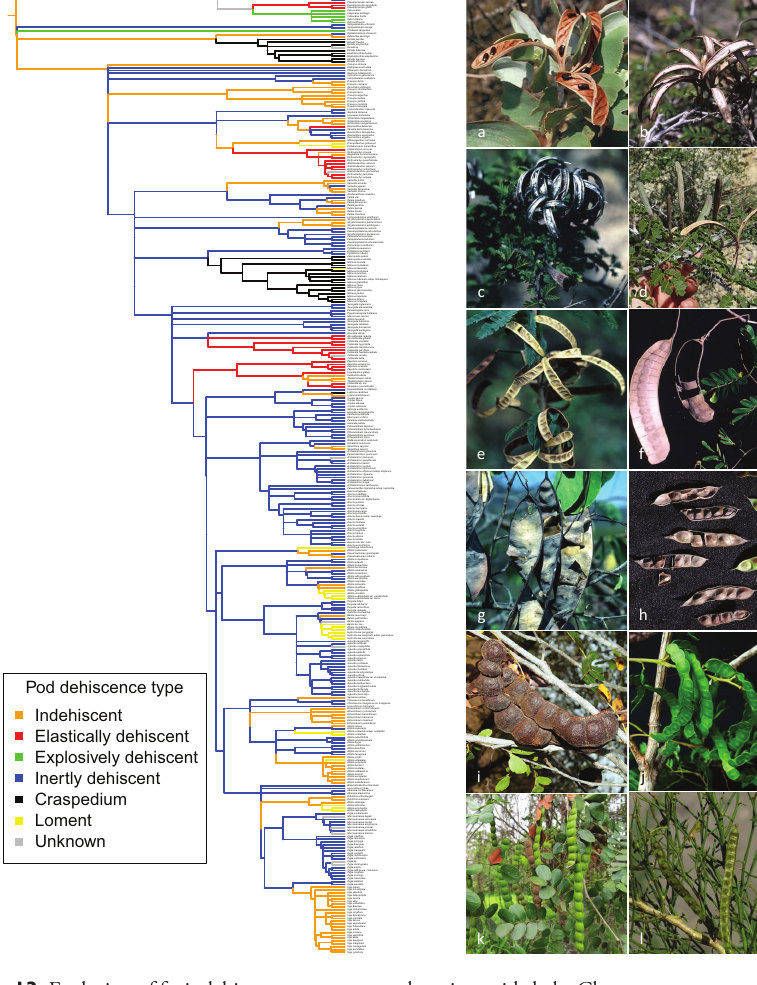
Figure 13. Evolution of fruit dehiscence types across the mimosoid clade. Character states were defined as: indehiscent ; inertly dehiscent along one or both sutures; explosively dehiscent , whereby the woody valves twist and split along both sutures along whole length of pod simultaneously; elastically dehiscent from the apex, the valves recurving, but not laterally twisting; craspedium , i.e. fruits breaking up into free-falling one-seeded articles leaving a persistent replum or whole valve breaking away intact from replum (valvately dehiscent); lomentiform fruit, i.e. the valves readily cracking between the seeds into one-seeded articles, taken here to include crypto-lomentiform fruits. Branch lengths are not informative in this figure. Photos a–e elastically dehiscent a Acacia argyraea Tindale b Calliandra prostrata Benth. c Calliandropsis nervosa (Britton &